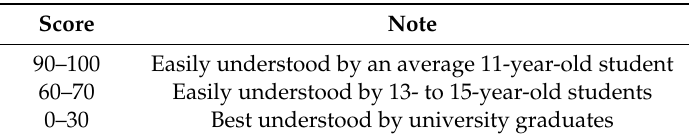
Table 2. Formula of Flesch–Kincaid